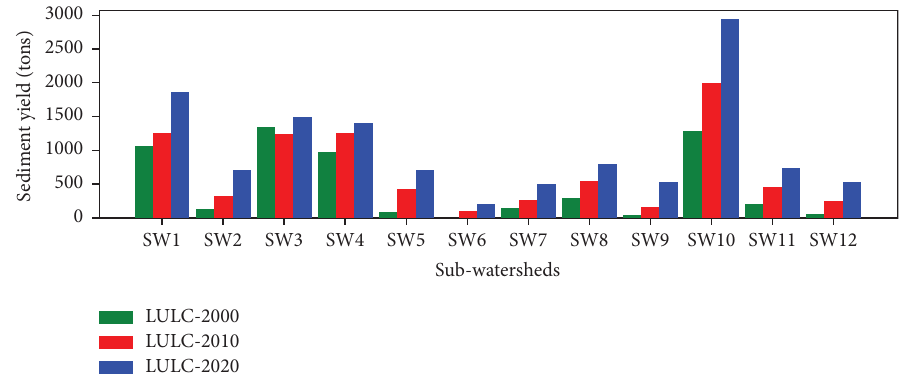
Figure 11: Sediment yields at the subwatershed level for LULC from 2000 to 2020. Table 11: Streamfow and sediment budget components and their variation under LULC